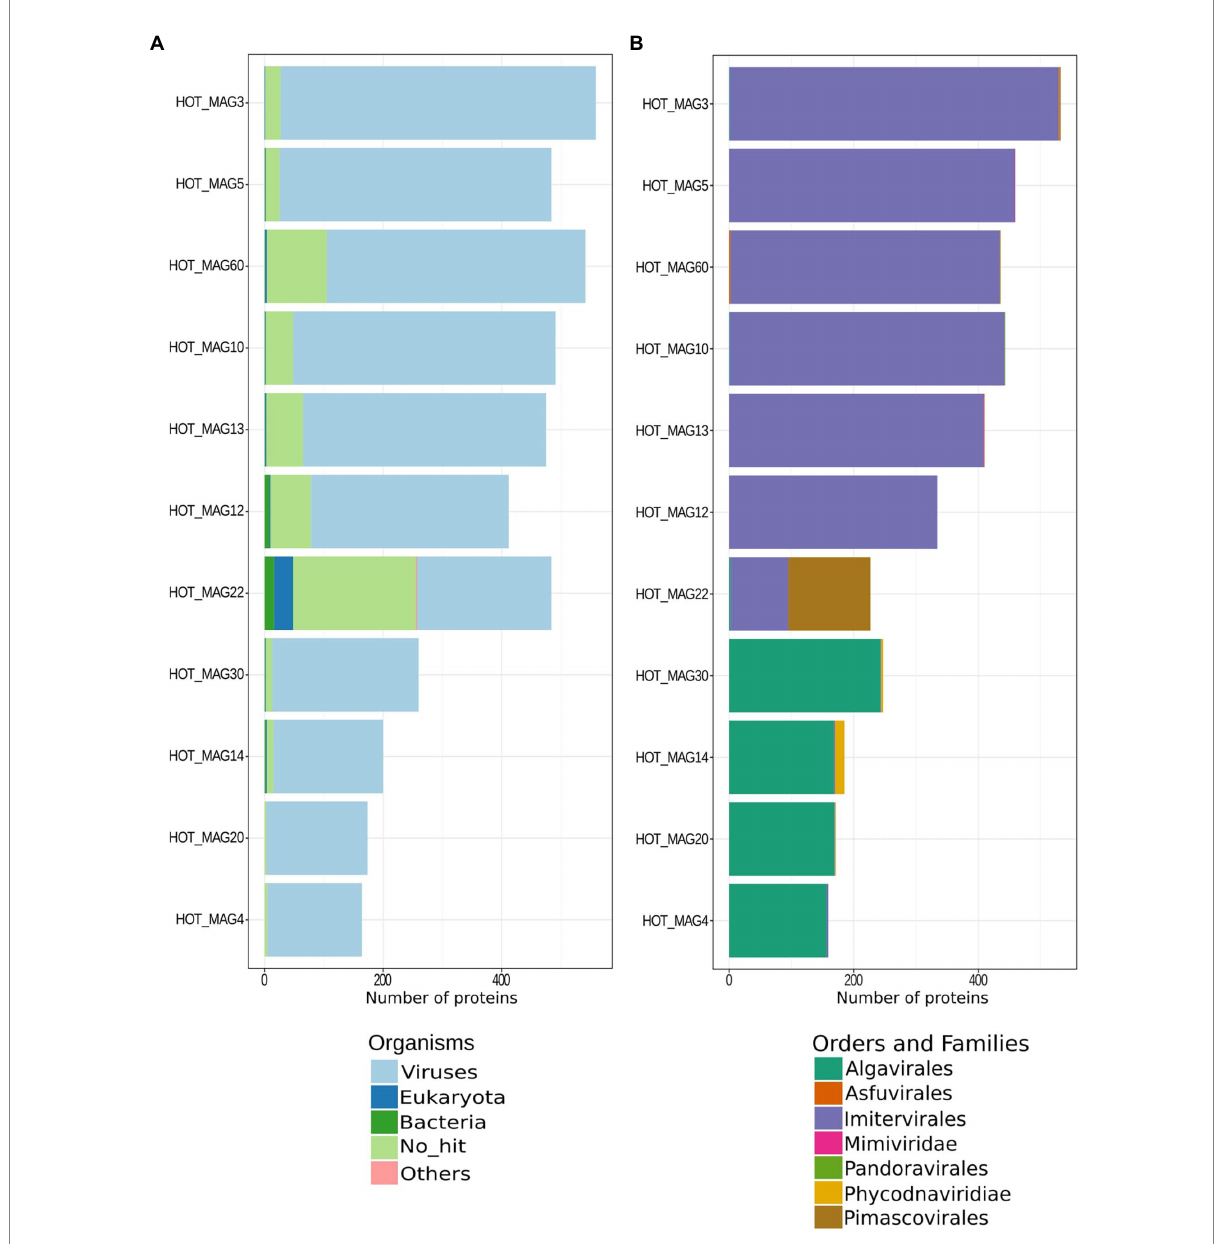
FIGURE 2 Best matches of predicted proteins identified in each HOT MAG. The results are based on a LAST-based homology search, with best hits retained (see Materials and methods for